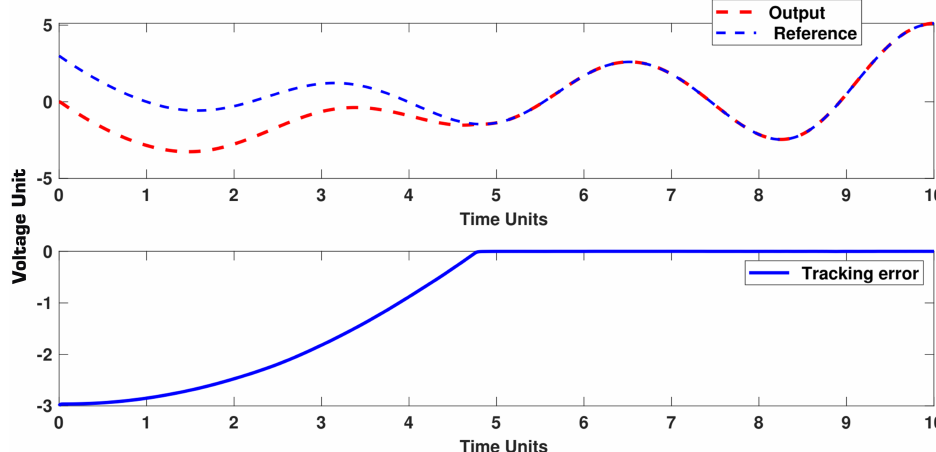
Figure 14. Example 3: Output and error signals, faulty condition.